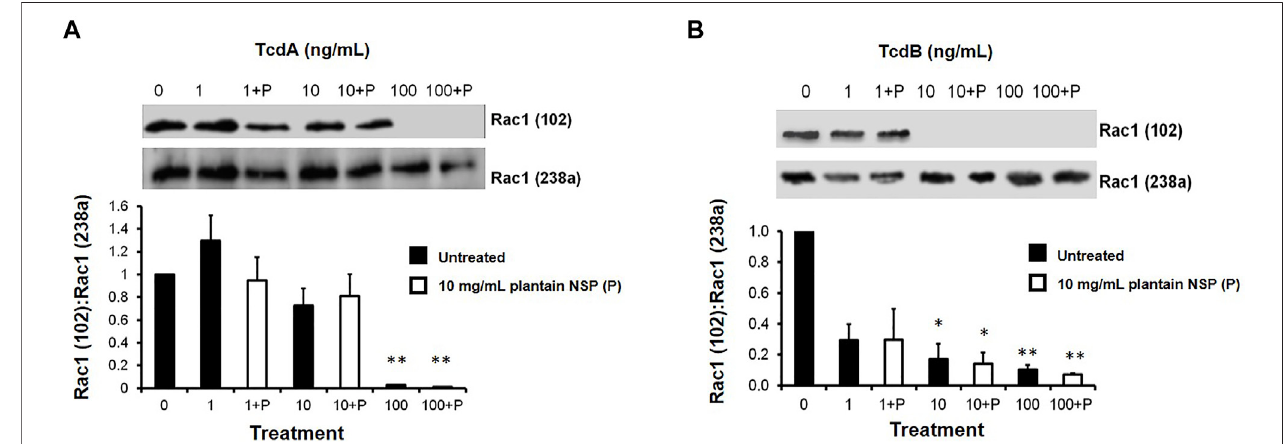
FIGURE 7 | C. dif fi cile toxins A and B mediate increased Rac1 glucosylation within intestinal epithelial cells, which is unaffected by pre-treatment with soluble NSP fromplantain.ImmunoblotanalysisshowsanincreaseinRac1glucosylationfollowingtreatmentwith10 ng/ml (A) toxinA(TcdA)for24 hand (B) toxinB(TcdB)for48 h, which is unaffected by pre-treatment of Caco-2 cells with 10 mg/ml soluble plantain NSP (P). Protein bands were analysed by chemiluminescence image densitometry. Mono-glucosylatedRac1levels(assessedwithantibody102)werenormalisedtototalRac1(assessedwithantibody238a),withrepresentativeblotsshownfor N (cid:2) 3 experiments, n (cid:2) 3 replicates. Signi fi cant differences from non-toxin treated controls, * p < 0.05, ** p < 0.01 and *** p < 0.001; Kruskal-Wallis test.